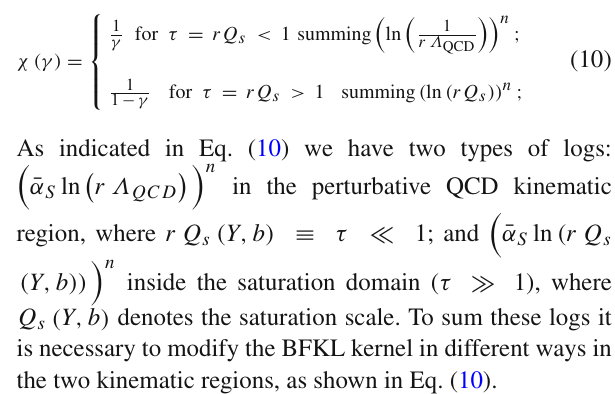
corresponds to the main contribution to Eq. (6). One can see that at τ = 1 ÷ 2 this curve shows τ ¯ γ behaviour. The red curve 3 ϕ in Eq. (15) is the angle between r and r (cid:5) . We hope that this angle will not be confused with the function φ of Eq.